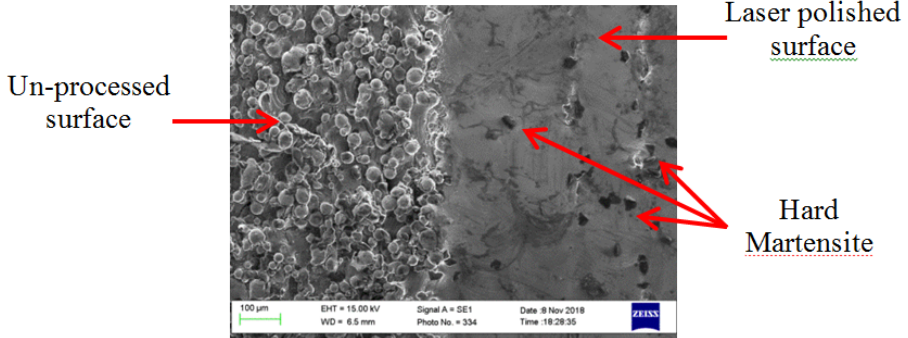
Figure 6. SEM image of AM 316L SST sample showing the same sample surface before (left) and after (right) laser polishing with 130 W, 30 rpm, and two passes repetition.